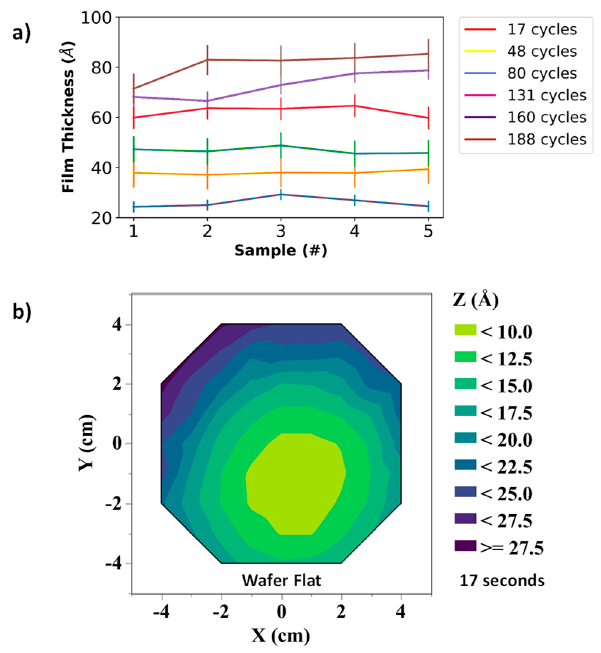
Figure 6. Uniformity measurements of (a) SiO 2 on (b) α‐ Si on a 4 ‐ inch wafer.